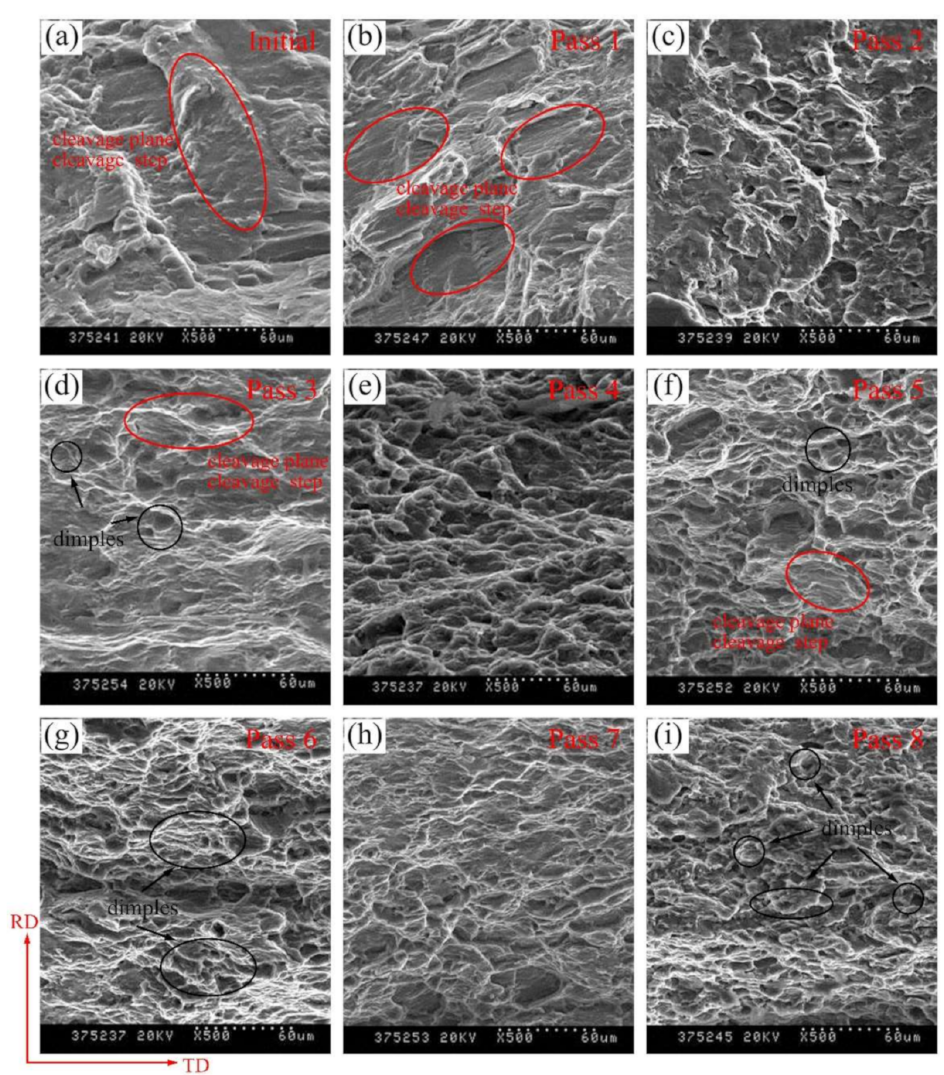
Figure 12. Fracture SEM characteristics of AZ31 tension samples fabricated by multi-pass lowered- temperature rolling: ( a ) Initial; ( b ) Pass 1; ( c ) Pass 2; ( d ) Pass 3; ( e ) Pass 4; ( f ) Pass 5; ( g ) Pass 6; ( h ) Pass 7 and (i) Pass